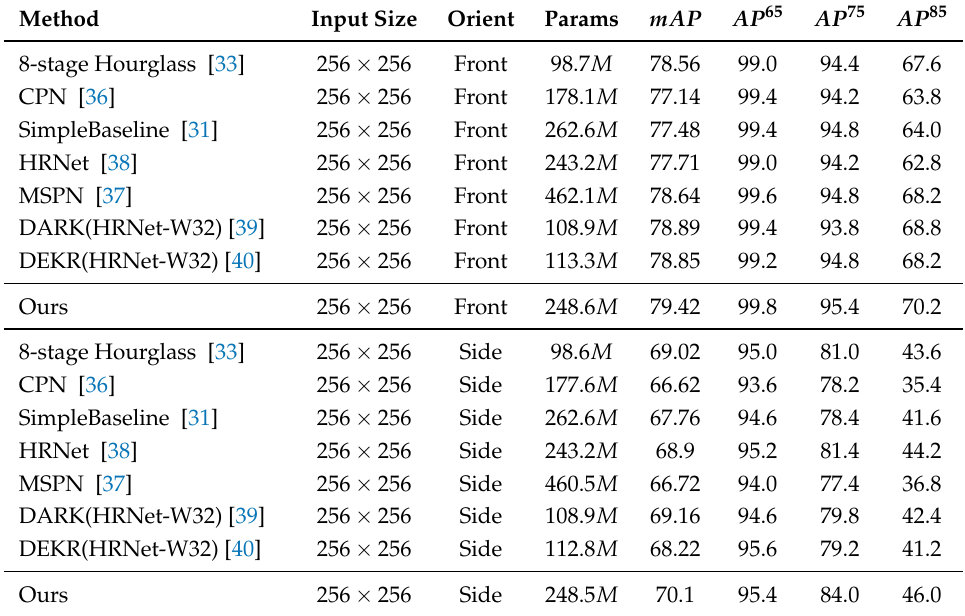
Table 1. Quantitative comparisons with other state-of-the-art methods based on our keypoint dataset. Method